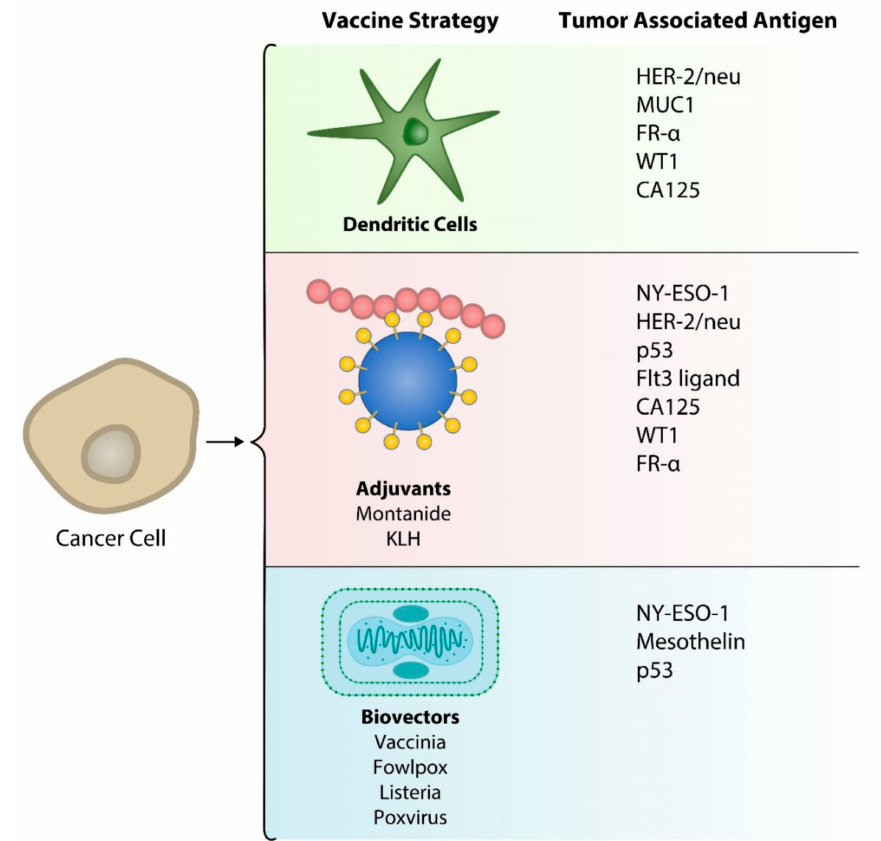
Figure 1. Strategies for presentation of tumor associated antigens in ovarian cancer